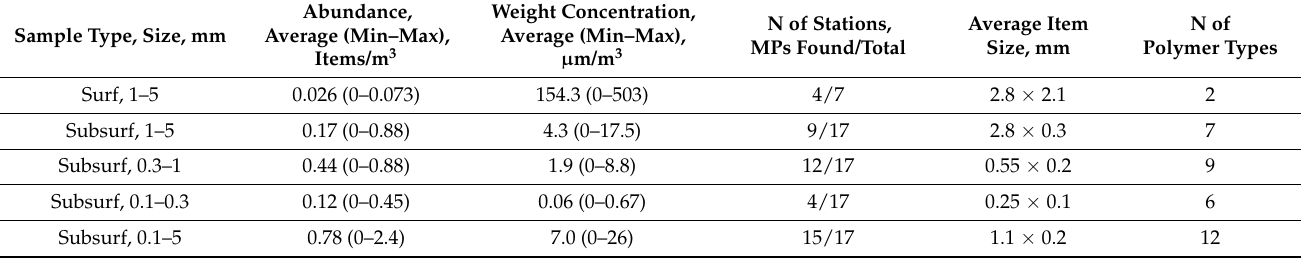
( left ) and subsurface ( right ).